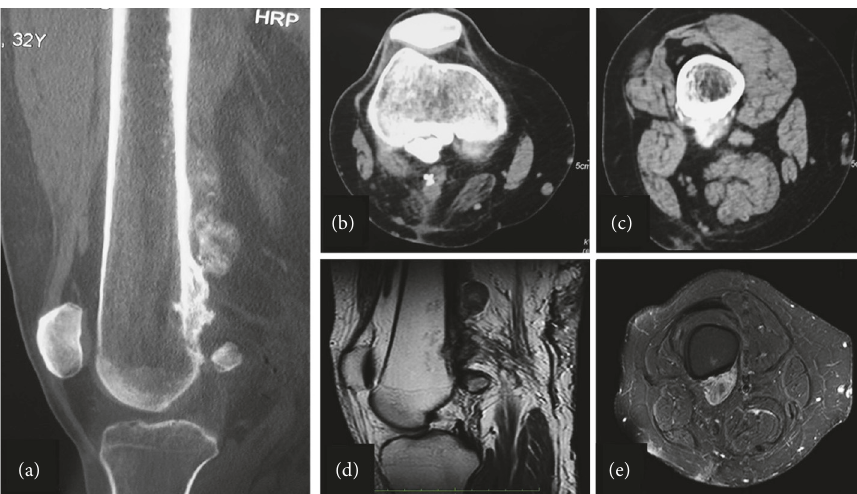
Figure 5: Computer tomography (CT) of the right femur in a 32-year-old male with parosteal osteosarcoma of the distal femur (a). Sagittal CT with multiple large-ossified masses adjacent to the posterior surface of the distal femur (b). Axial view displaying the tumor's broad-based stuck attached to cortical surface associated with dense central ossification and the cleft sign that separated the ground glass mass from the bone cortex, with no evidence of medullary involvement (c). Magnetic resonance imaging of the distal femur (sagittal (d) and axial (e) views) showing the round mass of low signal intensity on T1-weighted imaging. The cortex appears intact along the deep surface of the lesion.